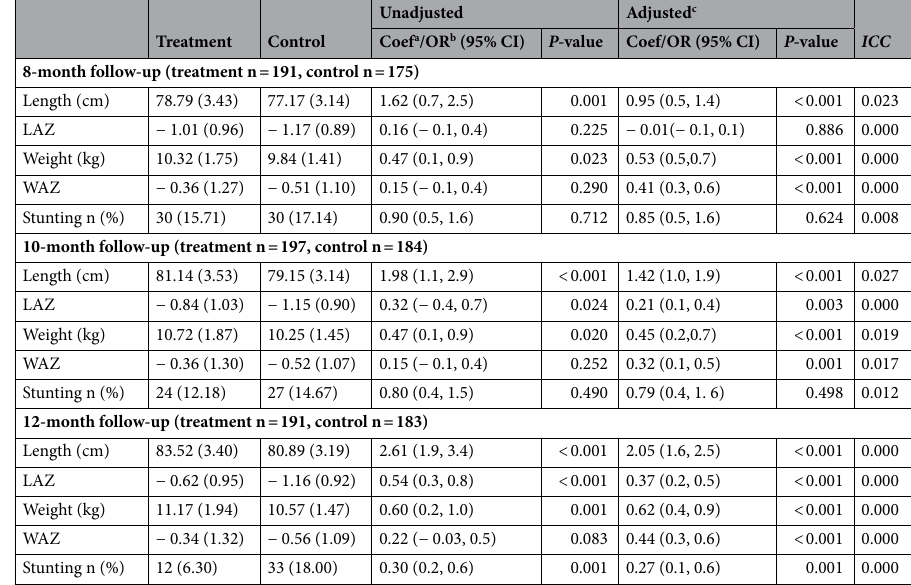
Table 3. Effect of intervention on growth at different follow-up times. Averages are presented as mean and standard deviation; a In the first model co-efficient were estimated using mixed effect linear regression; unadjusted and adjusted analysis was accounted for clustering. b Odds ratio were estimated using mixed effect logistic regression; unadjusted and adjusted analysis was adjusted for clusters. c Adjusted for group, age, sex, child’s baseline length, child’s baseline weight, mother’s height, and household asset index. Backward elimination stepwise covariate selection procedure was used; the models retained covariates with a P value of < 0.20 for the overall significance of the variables. No interaction terms with intervention were significant.